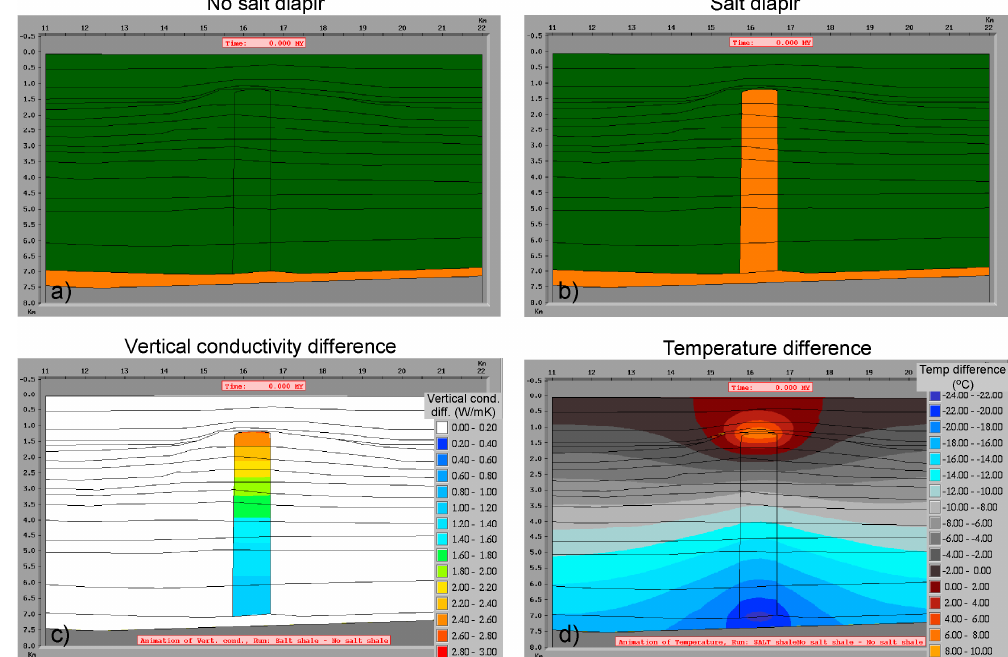
Figure 15. Temperature effect of salt in the synthetic simple model. B) Model without salt diapir, a ) and b ) with salt diapir (orange). c ) Difference in thermal conductivity between the two models, d ) temperature difference between the two models. Grey to blue colors: Colder sediments in salt diapir model. Brown to red colors: Higher temperature in diapir model.